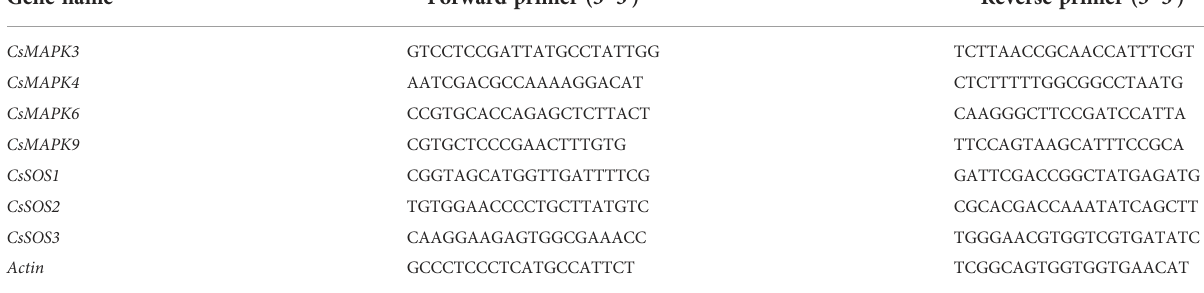
TABLE 1 Primer sequences for